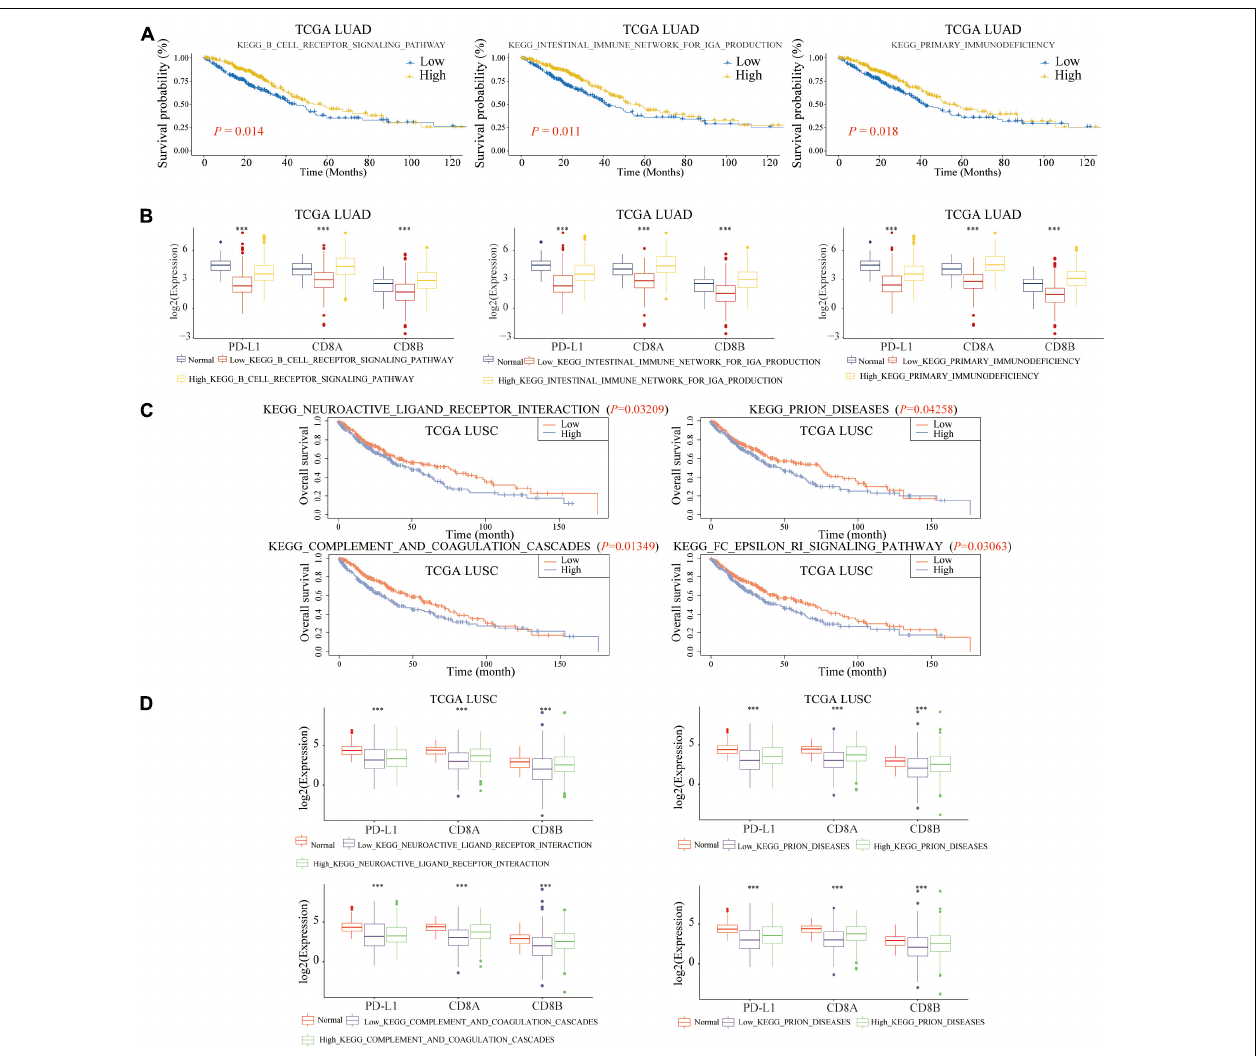
FIGURE 14 | Molecular mechanisms of B cell and DC1 predicting the OS and ICB efficacy of LUAD and LUSC patients. For LUAD patients, the above three KEGG pathways clarified the potential mechanisms of B cell predicting (A) the ICB efficacy and (B) the OS. The above four pathways elaborated the molecular mechanisms of DC1 predicting (C) the ICB efficacy and (D) the OS in LUSC patients. *** p < 0.001.